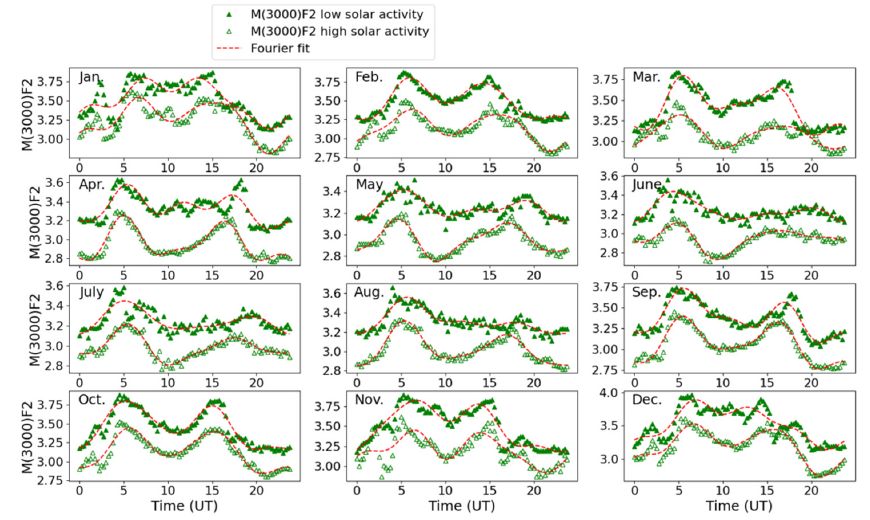
Figure 2. Same as Figure 1, but for M(3000)F2.